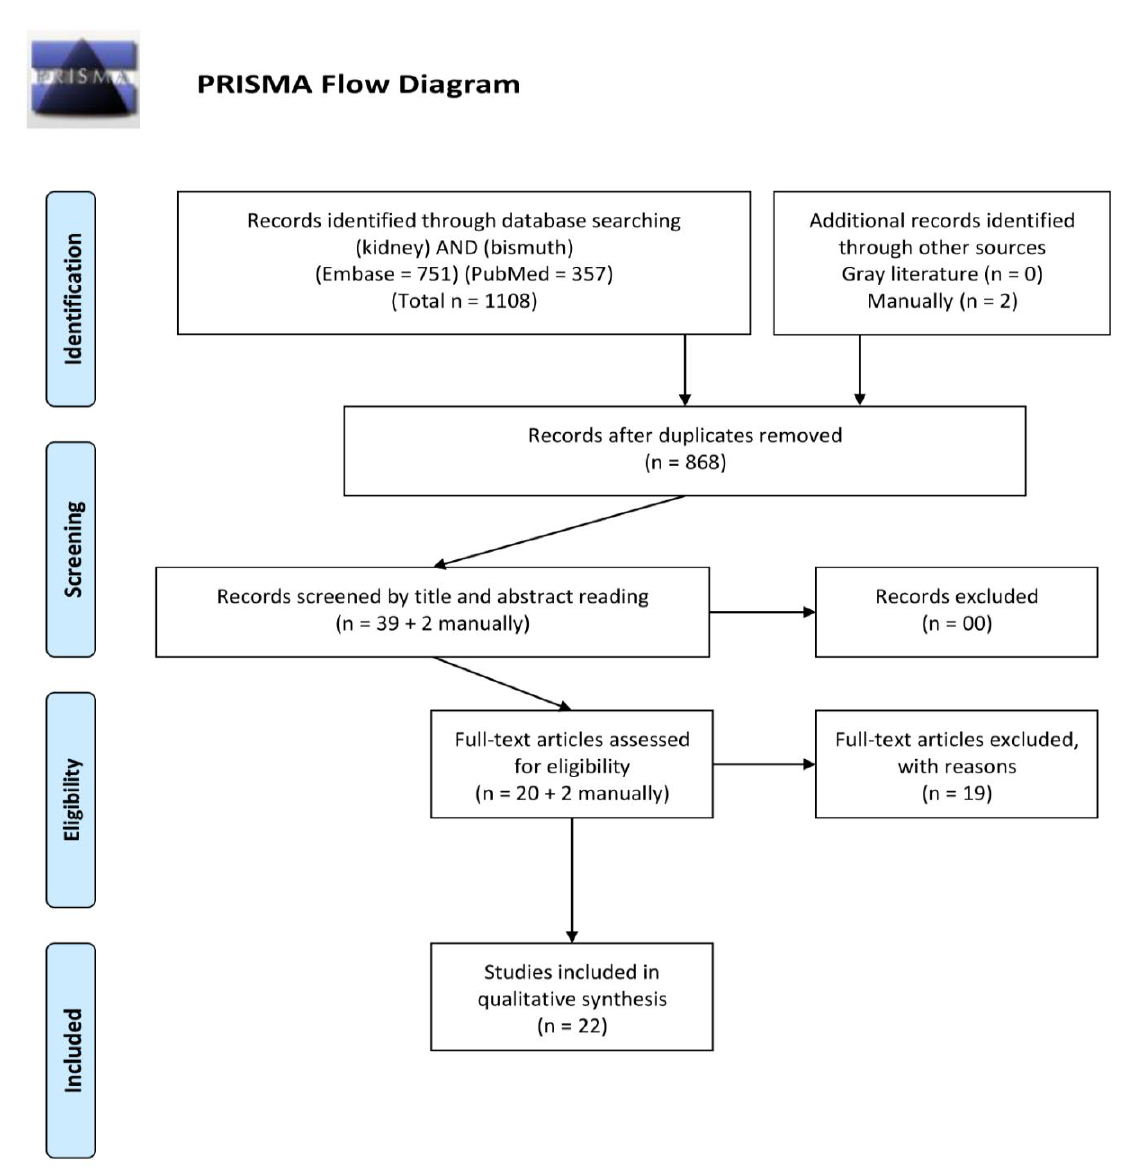
Figure 1. PRISMA flow